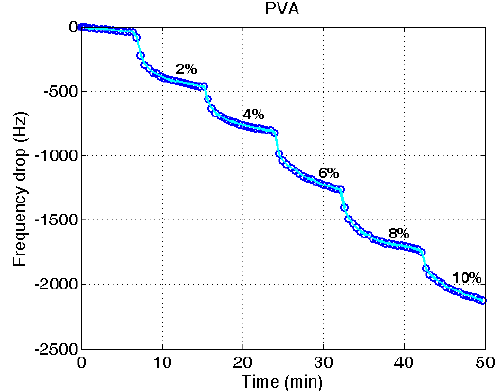
Figure 5. Variation of resonant frequency of a PVA-coated quartz crystal microbalance with increased water content.